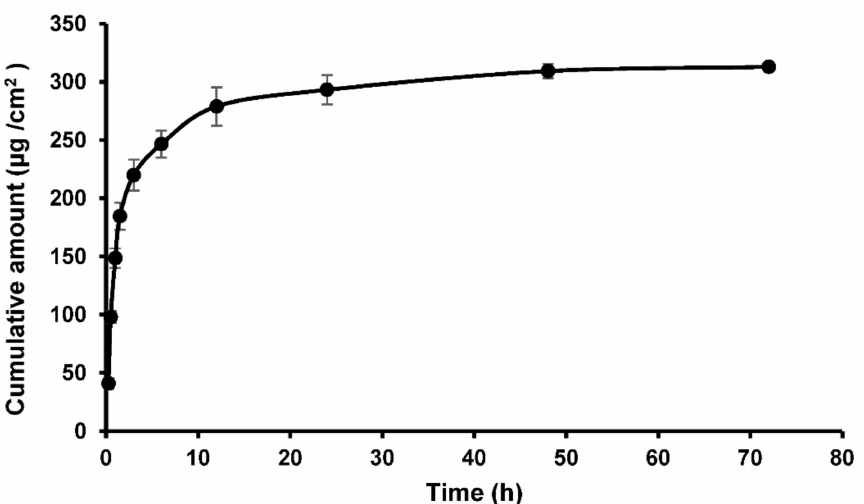
Figure 5. Permeation of PMD through full-thickness porcine skin; permeation of the copolymer was not detected at any time point. Data are mean ± SD ( n = 6); there error bars are within the symbol where not seen.